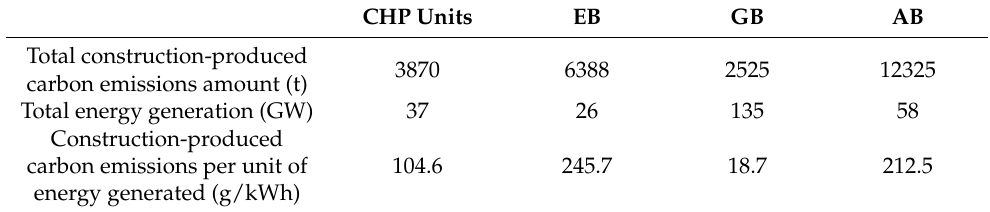
Table 5. Carbon emissions results of EH devices.